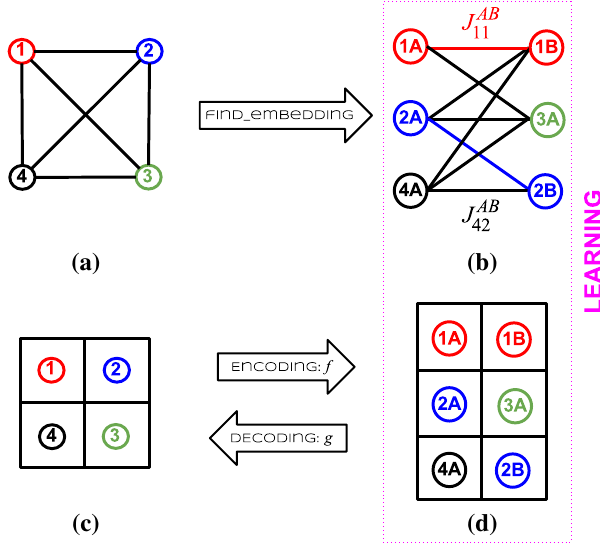
FIG. 2. Hardware-embedded models. (a) We first define a graph witharbitraryconnectivitybetweenthelogicalvariablesthatdirectly encode the data set to be modeled; here, we show a fully connected graph on four variables as an example. Such a graph serves as a scaffolding to build hardware-embedded models with enhanced modeling capacity. (b) We then embed the scaffolding graph in quantum hardware by using minor embedding techniques; this requirestheintroductionofauxiliaryqubits,couplings,andfields.In theexampleshownhere,thelogicalvariable1(red)isencodedusing two qubits, 1 A and 1 B , which are connected by an auxiliary coupler J AB 11 ;thesameistrueforvariable2(blue).Theblacklinkscorrespond to couplings between qubits representing different logical